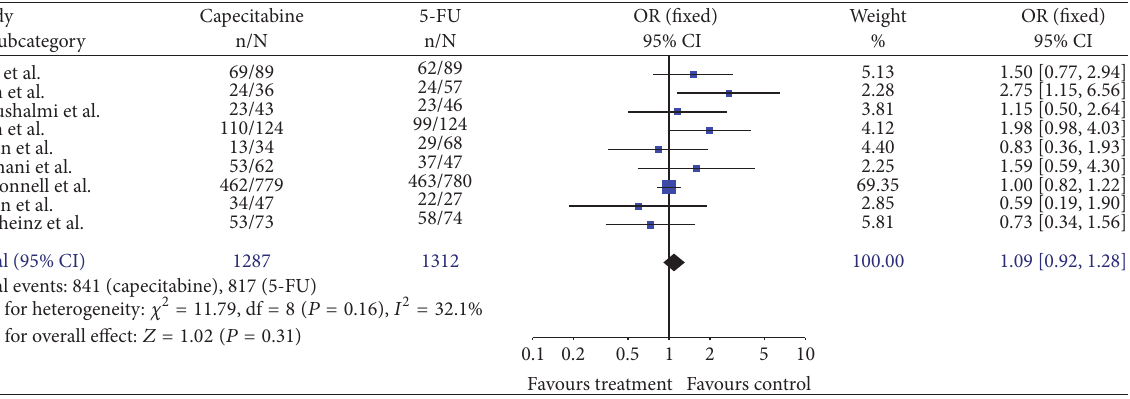
Figure 6: Forest plot of odds ratio (OR) for sphincter-sparing resection rate.